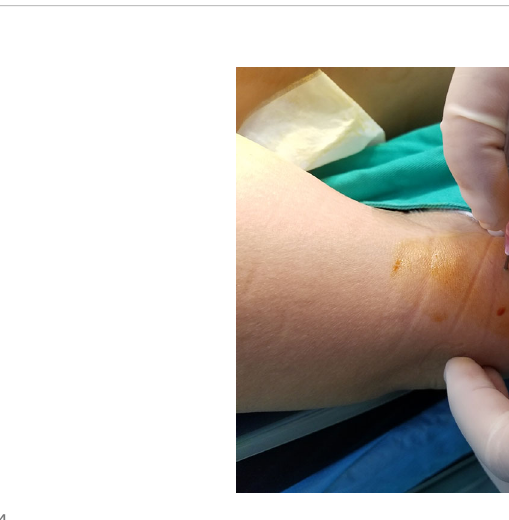
FIGURE 4 Forearm brachioradialis muscle by homogenate injection.